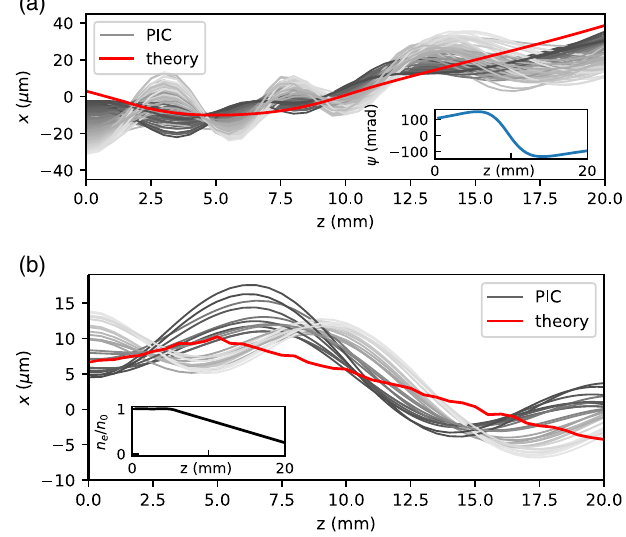
FIG. 2. (a) Electrons transverse position along propagation from a 2D PIC simulation (gray) and theory for transverse equilibrium position (red line) for dynamic steering: The plasma ¼ 3 × 10 17 cm − 3 . The 24 fs y -polarized density is constant at n e laser pulse is focused to a 20 μ m waist at z ¼ 10 mm with a 0 ¼ 1 . 3 , where quasilinear approximation roughly holds. The subset shows the PFT angle evolution due to β ¼ 0 s, ζ ¼ − 0 . 5 mm fs, and φ ¼ 500 fs 2 at focus, leading to a 50% 2 intensity drop. The initial electron energy is 10 MeV. The discrepancy for z < 2 . 5 mm is due to the beam injection at z ¼ 0 mm. (b) The same quantities plotted for down ramp steering: The density drops linearly from 5 to 2 × 10 16 cm − 3 between z ¼ 5 mm and z ¼ 20 mm. The laser pulse with w 0 ¼ 180 μ m and a ¼ 0 . 5 is collimated, with a constant PFT angle 0 ψ ≃ 64 mrad due to τ ¼ 150 fs, β ¼ 0 . 02 fs, ζ ¼ 0 fsm, and φ ¼ 100 fs 2 at focus. The initial electron energy is 5 MeV. The 2 intensity drop is